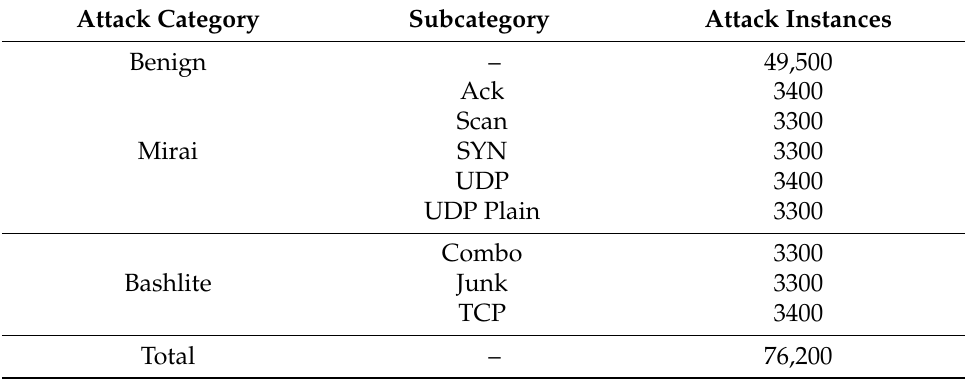
Table 3. Dataset description.